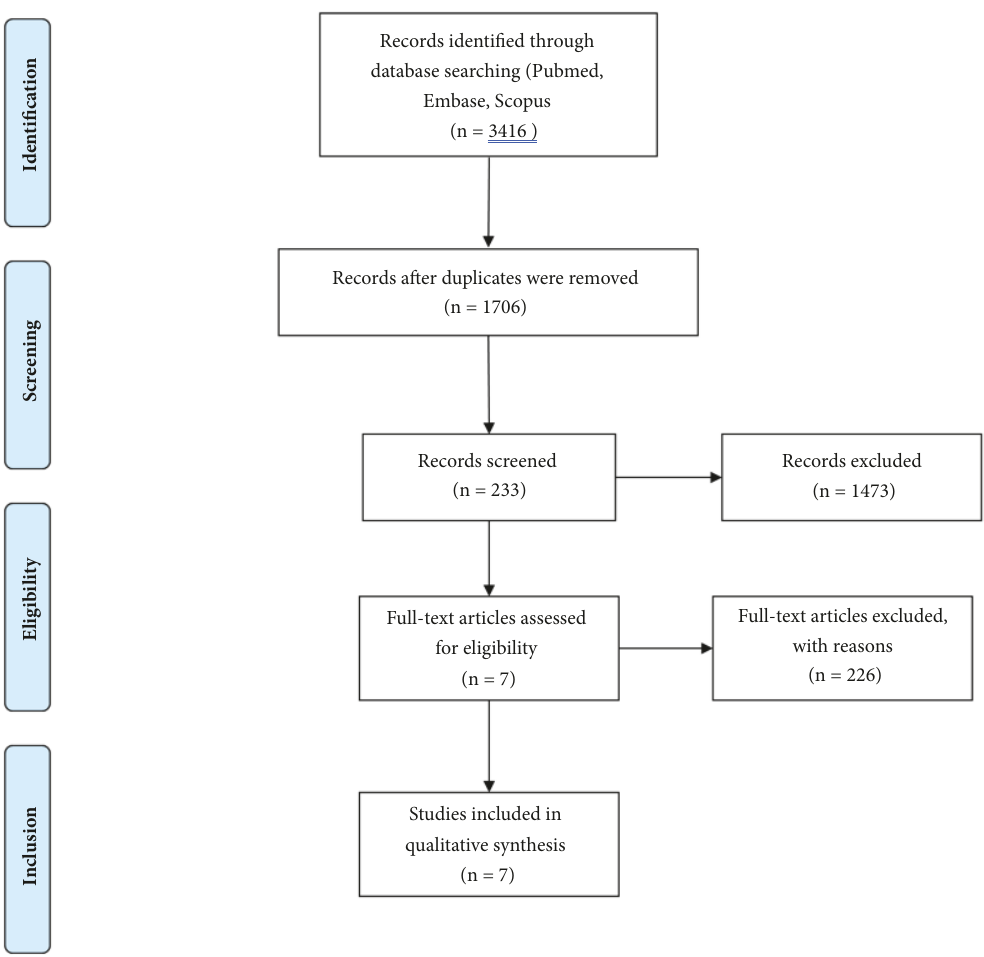
Figure 1: Preferred Reporting Item for Systematic Reviews and Meta-Analyses (PRISMA) flow diagram for article